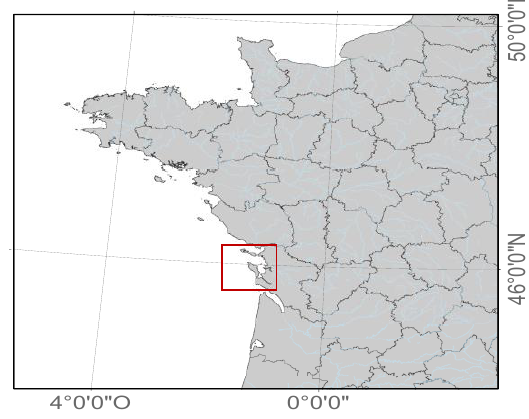
Figure 1: Localisation of the study area.